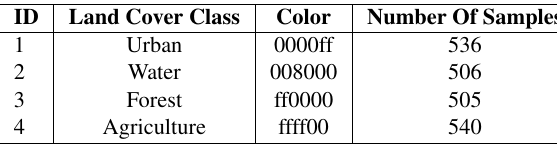
Table 3: Training Points & Color legend of landcover classes (Kohavi, R. and Provost, F.,1998). By using confusion matrix